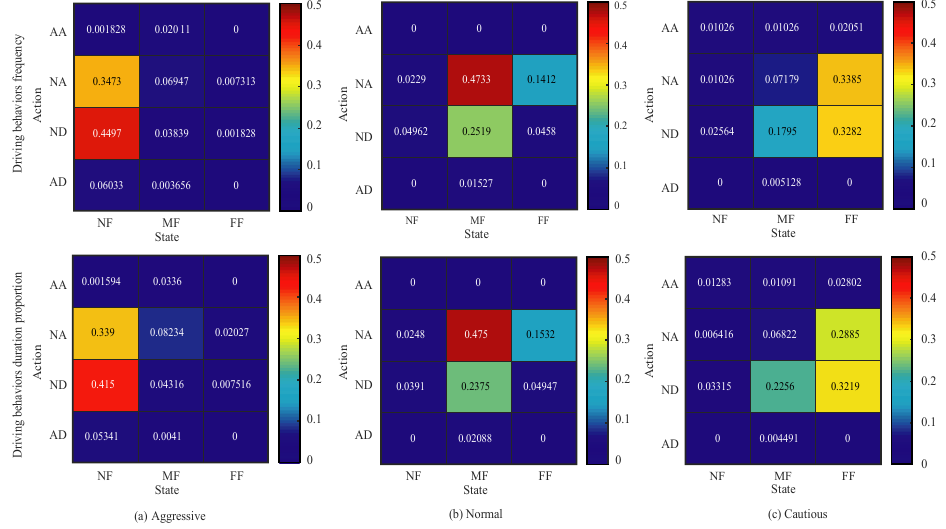
Figure 15. Frequency distribution and duration proportion distribution of driving behaviors of drivers with different styles.